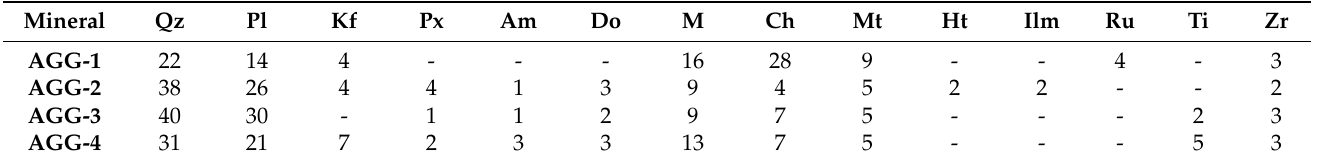
Table 3. Mineralogical composition (wt.%) of the studied whole